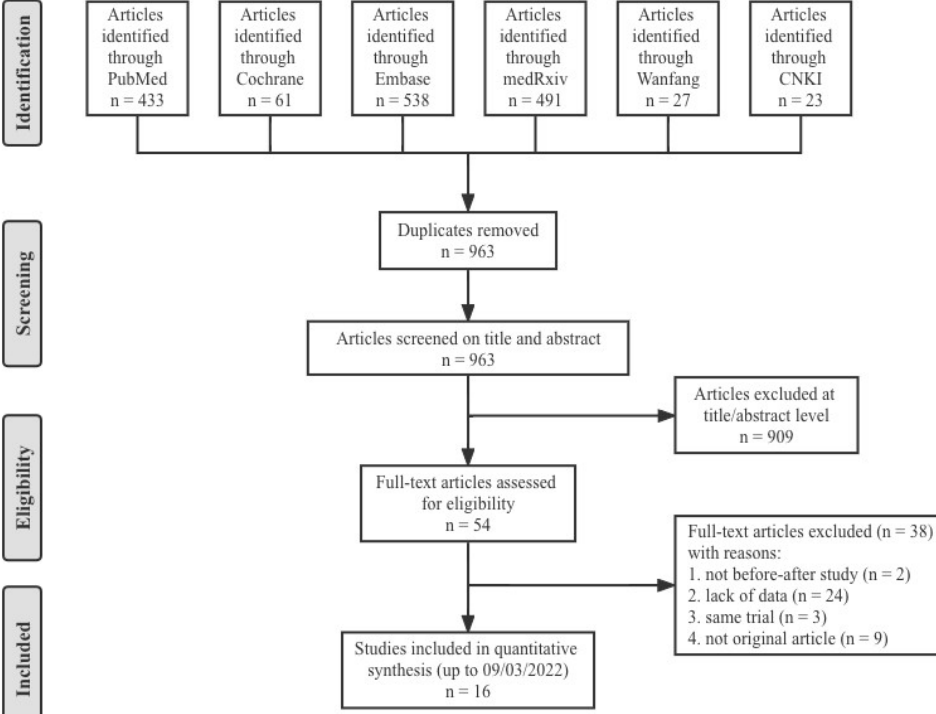
Table 1. The study populations (a total of 3134 subjects) were all general populations with- out history of laboratory-confirmed COVID-19. Therefore, the antibody responses were totally induced by the vaccines. The quality of the studies, evaluated by the NOS, are also provided in Table 1. Fifteen studies had a score of 7 to 9, indicating good quality and one study had a score of 6, indicating moderate quality.